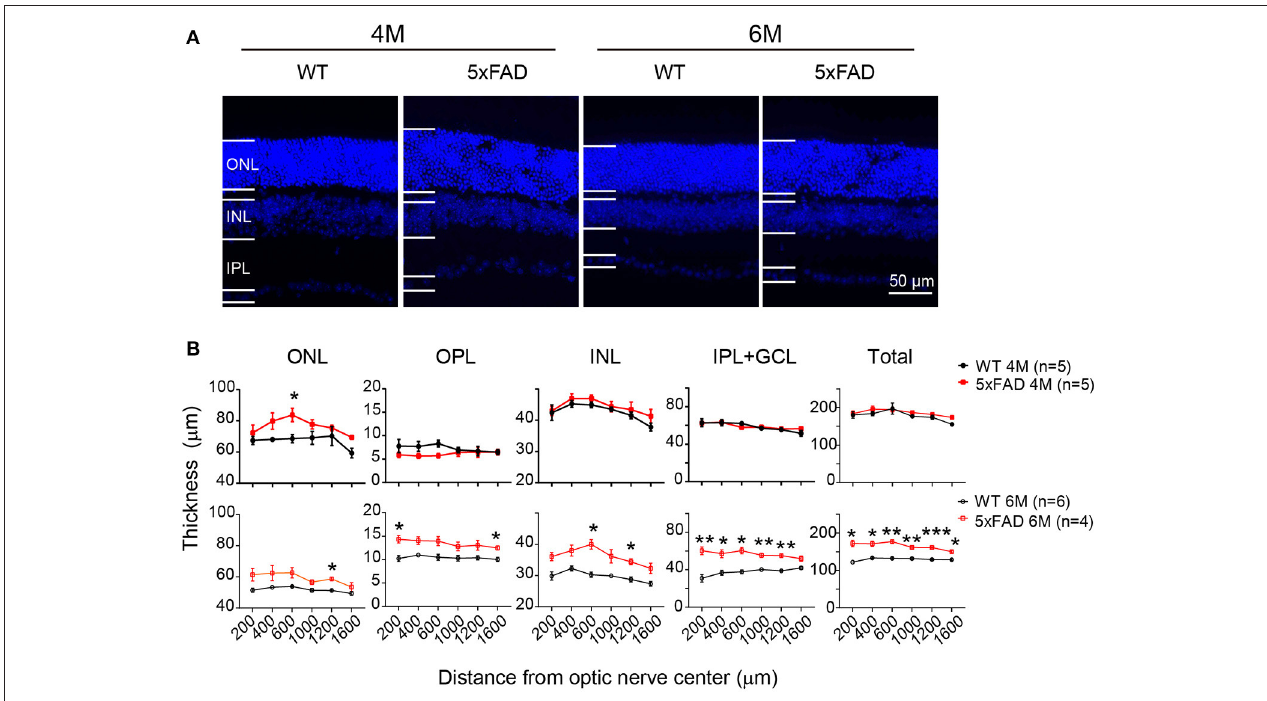
FIGURE 8 | Retina is abnormally thick in 5xFAD mice already at 4 months. (A) Images of DAPI staining of retinal slices from a WT and 5xFAD mice at 4 and 6 months. (B) Retinal thickness from the center to periphery for ONL, OPL, INL, and IPL with GCL layers and the total thickness at 4 months (top panel) and 6 months (bottom panel). The retina of 5xFAD mice is thicker than that of WT at 6 months. ONL, outer nuclear layer; INL, inner nuclear layer; GCL, ganglion cell layer. Data shown as mean ± SEM. * p < 0.05, ** p < 0.01; *** p < 0.001, two-way ANOVA with repetitive measurement. n, number of animals tested.